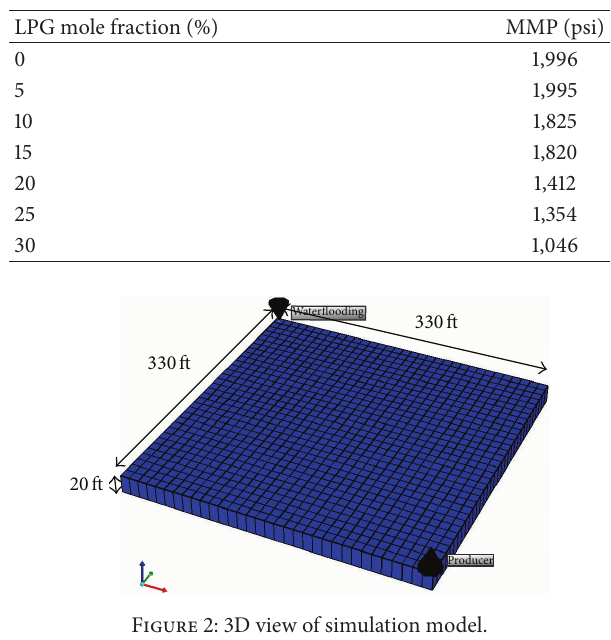
Table 3: MMP estimates for injection gas according to LPG mole fraction.